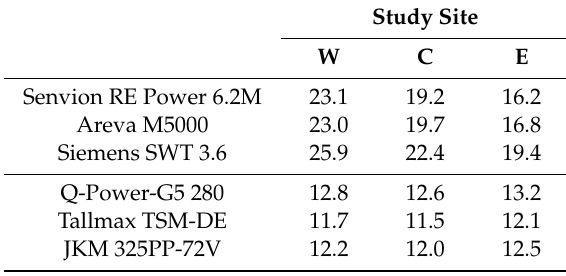
Table 3. Capacity factor ( CF , with units of %) of six commercial renewable energy technologies (three wind turbines and three PV panels) at the three study sites.